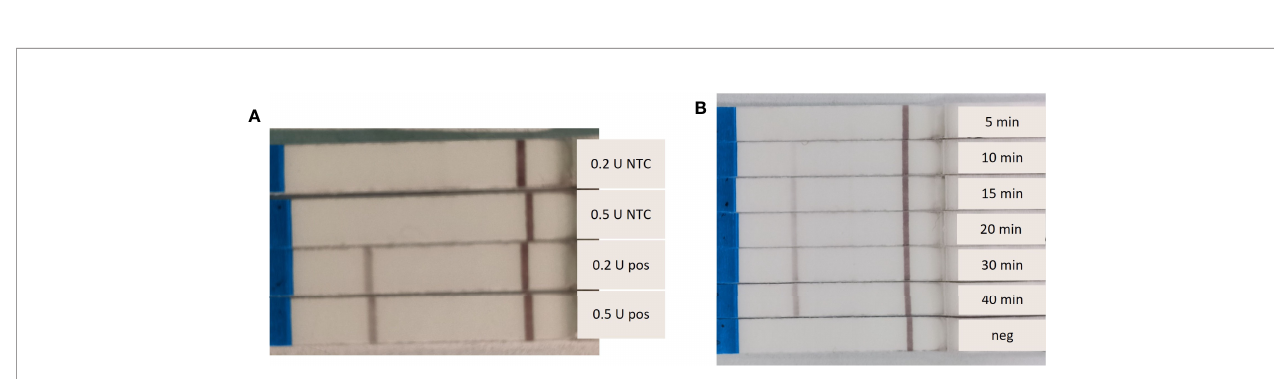
FIGURE 1 | Agarose gel visualizations of the in vitro tests of 7 initial primer combinations. Each primer combination was tested with 2 ng of Sabella spallanzanii DNA and with water as negative control ( “–” ).